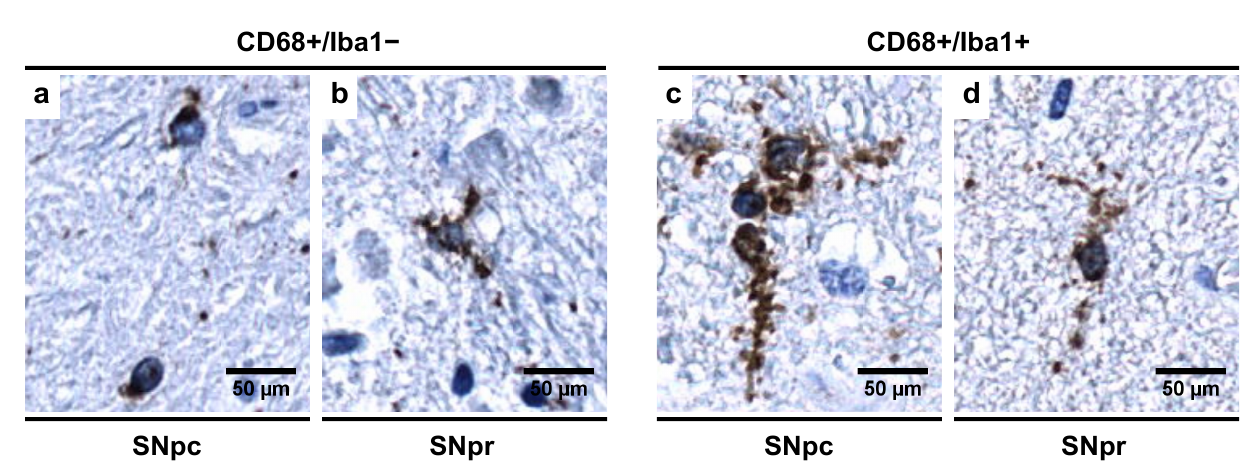
Figure 9. Morphology of different microglial subpopulations as seen in ( a , c ) SNpc and ( b , d ) SNpr. In CD68+/Iba1 − subpopulation (dominant in controls in SN region), ( a ) microglia is sparsely branched in SNpc while ( b ) show complexity in cell processes in SNpr. This subpopulation represents microglia in “ controlled phagocytotic activated state ”. In CD68+/Iba1+ subpopulation (dominant in alcoholics in SN region), ( c , d ) microglia shows dystrophic changes seen as by appearance of beaded processes in SNpc and SNpr. Original magnification, 400 × . Scale bars, 50 µ m.